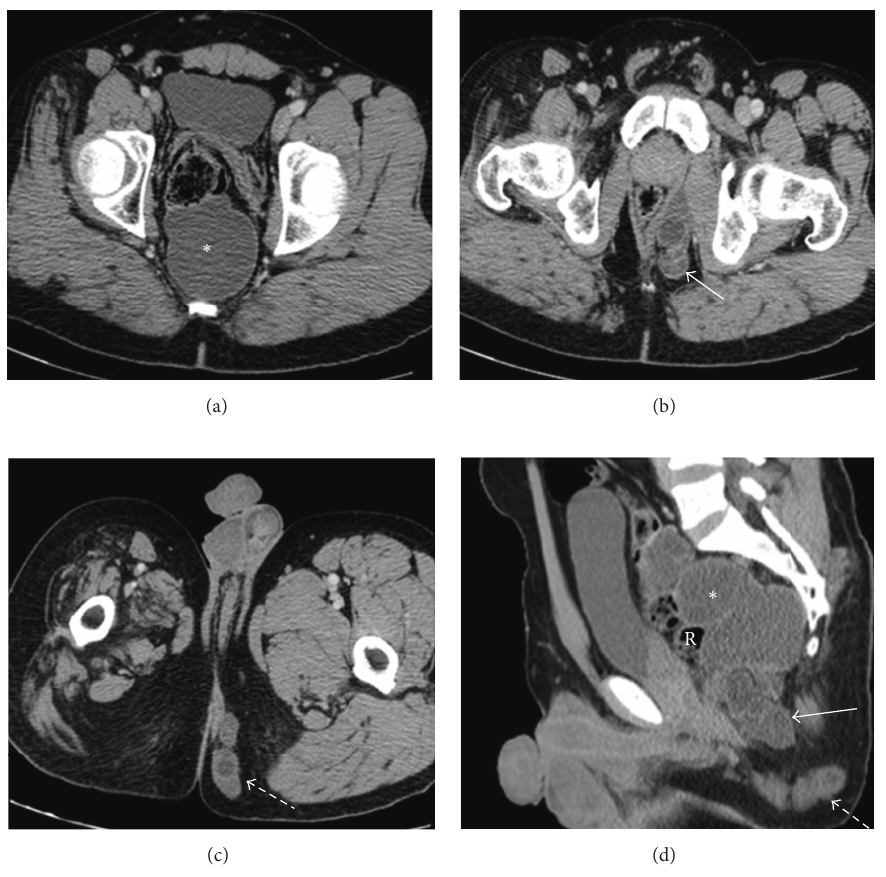
Figure 1: Multiple axial and sagittal contrast enhanced CT scan show a multilocular, hypoattenuating, retrorectal cystic lesion (asterisks) displacing the rectum (R) anteriorly. The left ischioanal fossa cystic lesion (solid arrow) shows enhancing wall and internal septations, breaching the left levator ani muscle and extending into the left perineal subcutaneous fat (dashed arrow). Atrophy of the right hemipelvis and proximal thigh muscles is noted and related to known